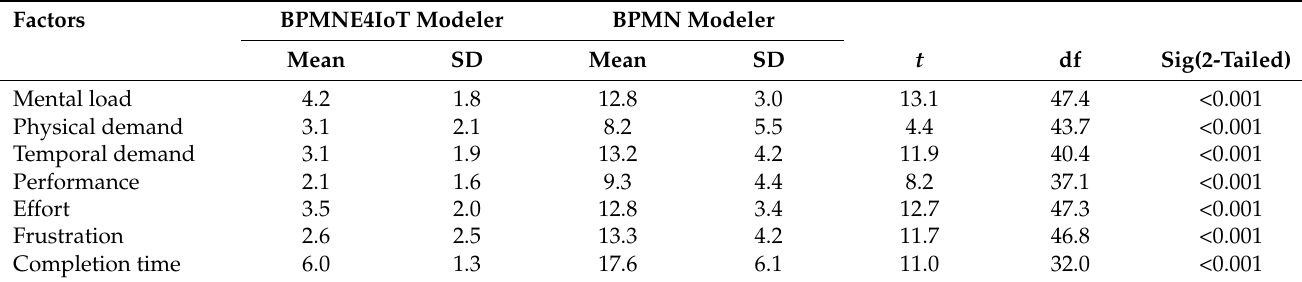
Table 7. Two-Sample T-Test Results for BPMNE4IoT and BPMN